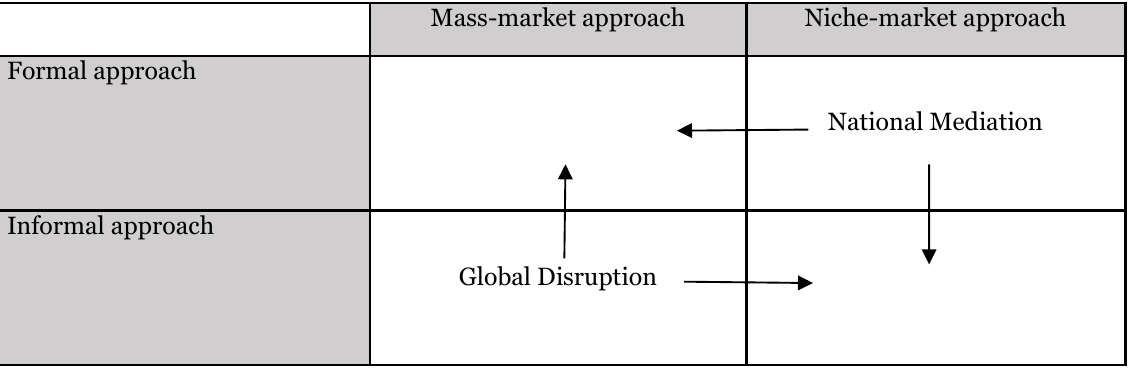
A Typology of MOOCs and Development